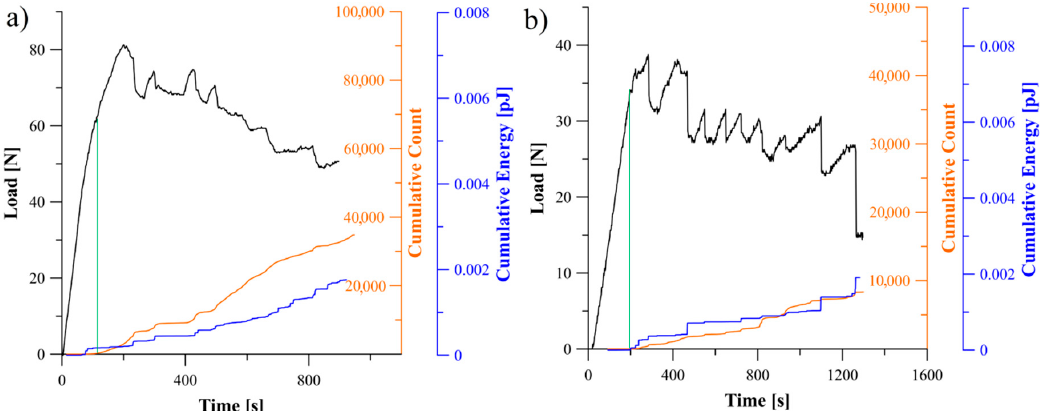
Figure 11. Relation between load, cumulative count and energy of AE signal obtained during the DCB experiment: ( a ) for specimen with 60 ◦ // − 60 ◦ delamination interface, ( b ) for specimen with 0 ◦ // 30 ◦ delamination